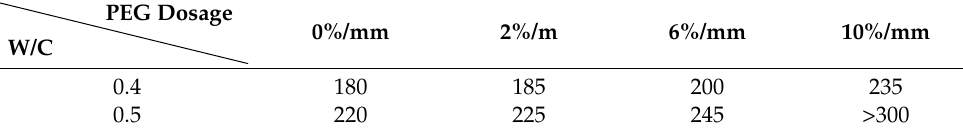
Table 5. Effect of PEG-600 dosage and water–cement ratio on the fluidity of cement paste.